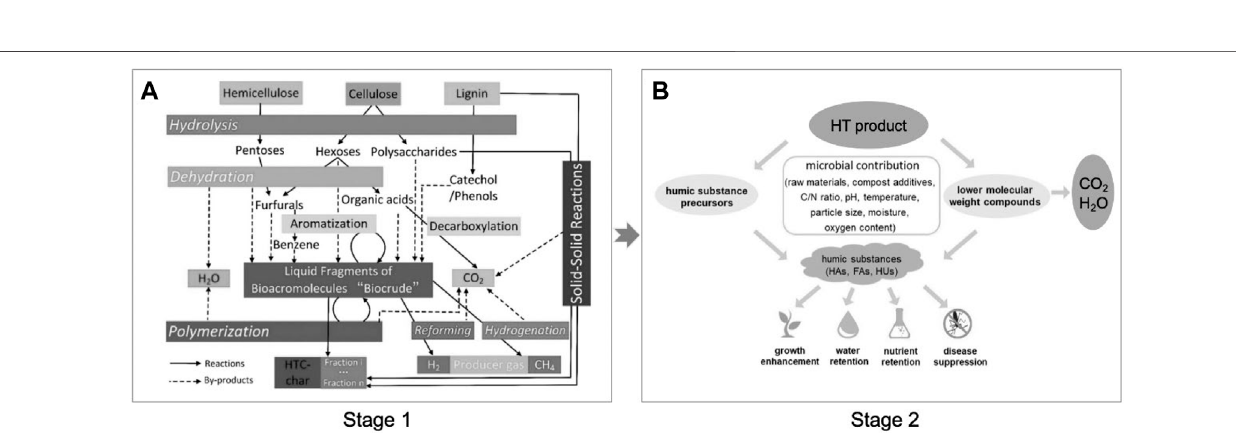
Frontiers in Bioengineering and Biotechnology |